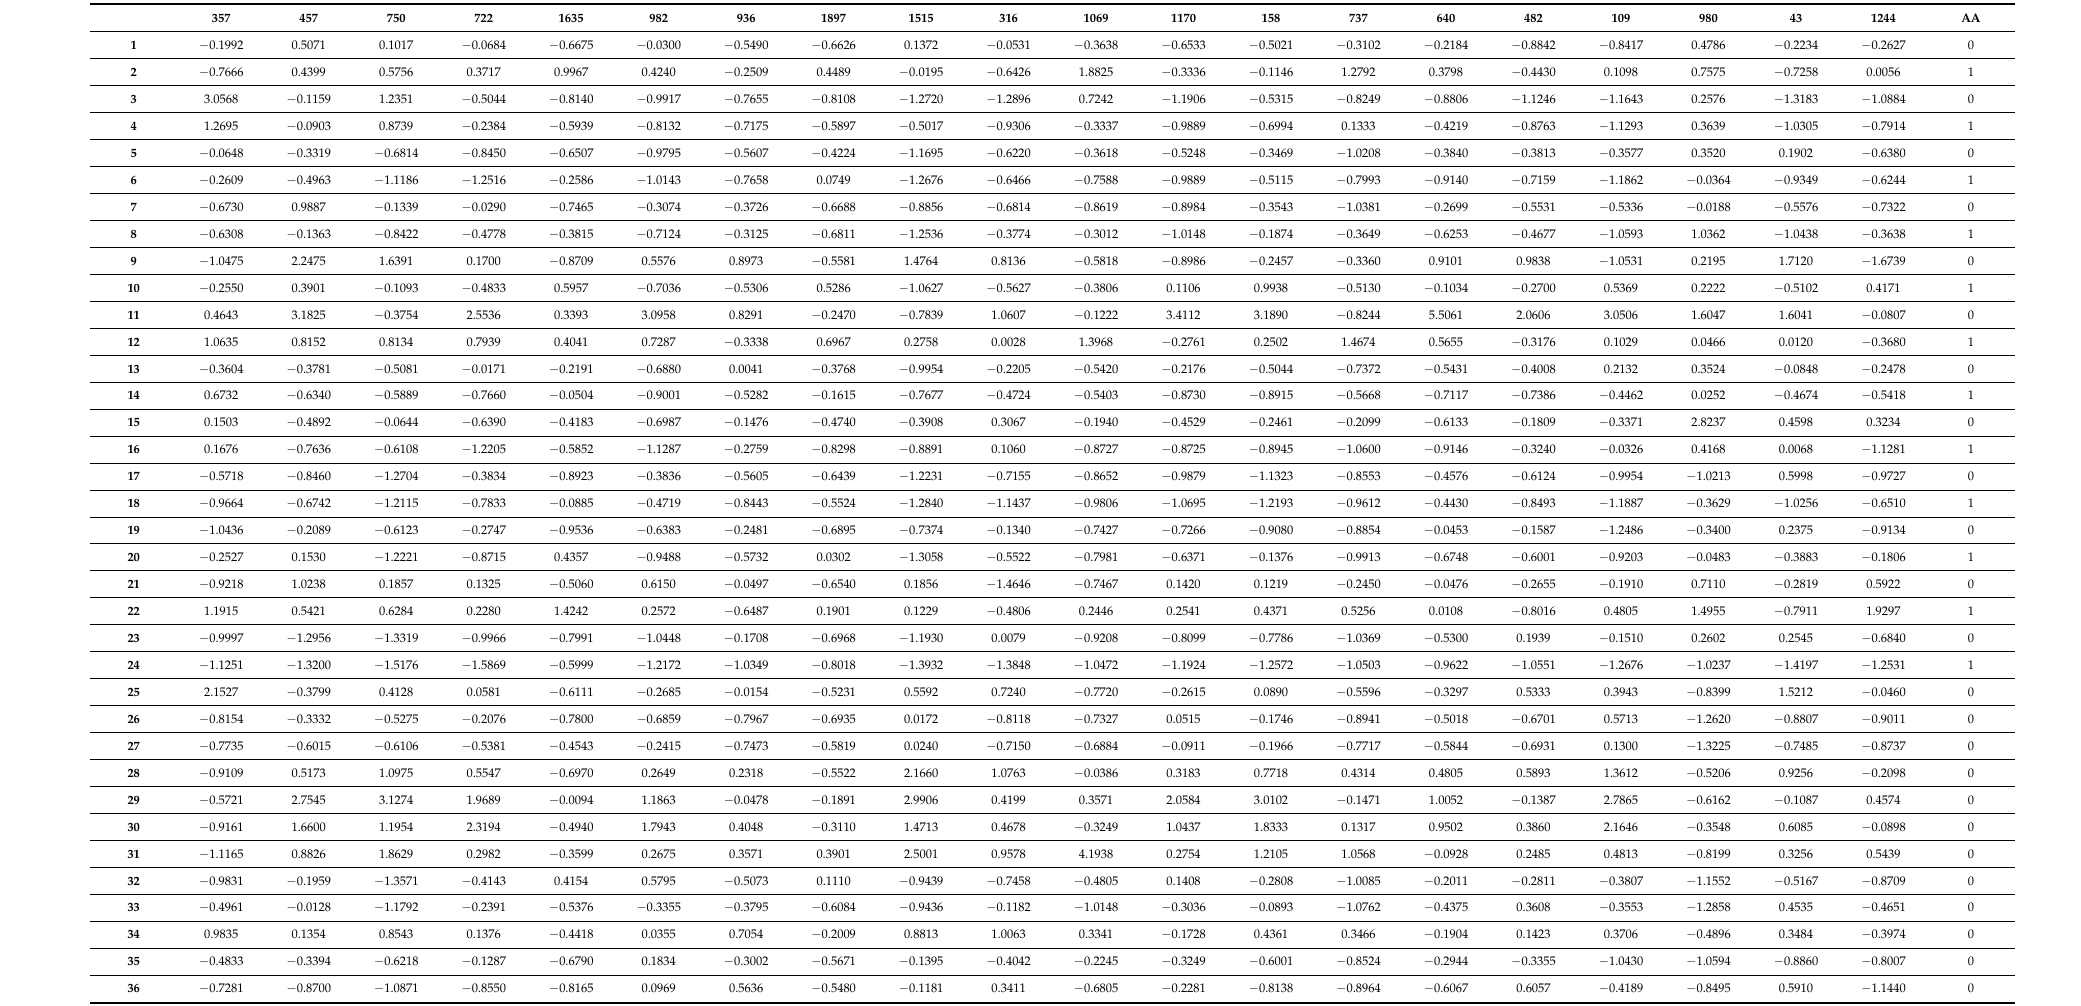
Table 2. 20 representative genes used in modified harmony search expression